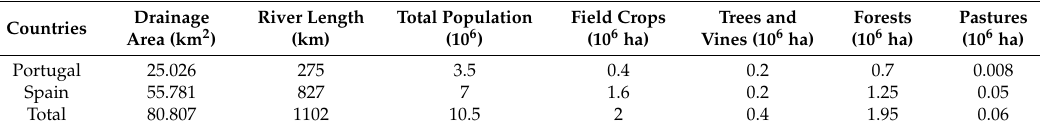
Table 1. Tagus River and land use